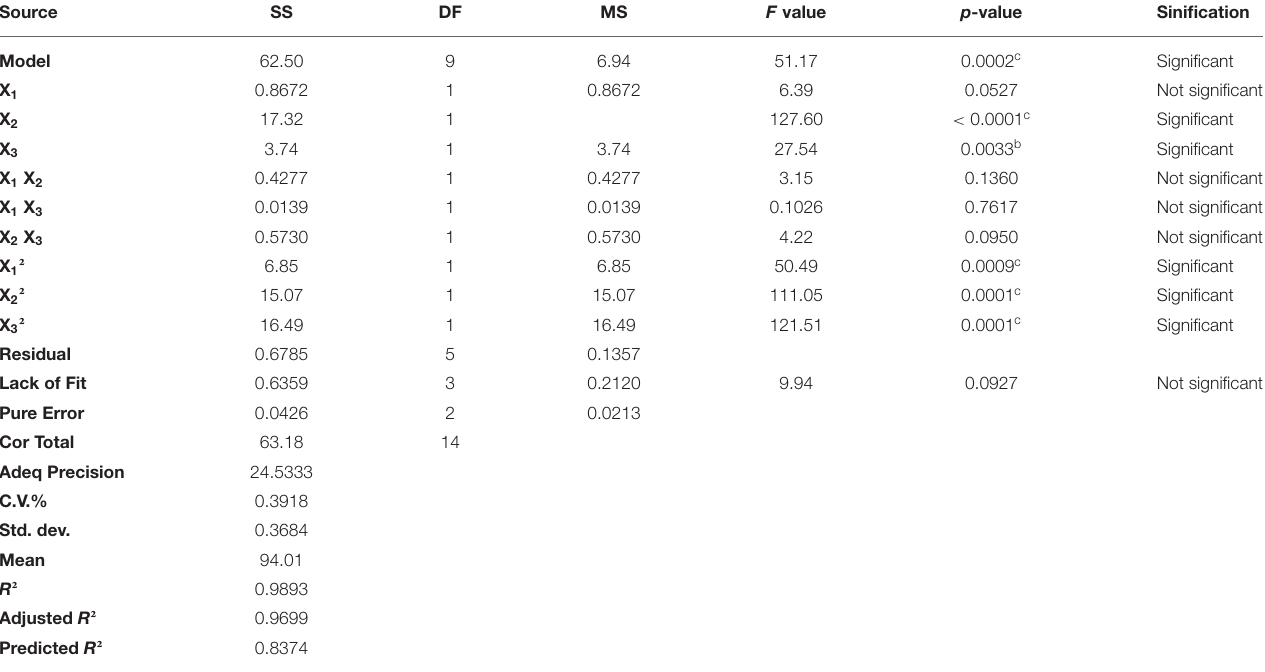
TABLE 2 | ANOVA for response surface quadratic model of